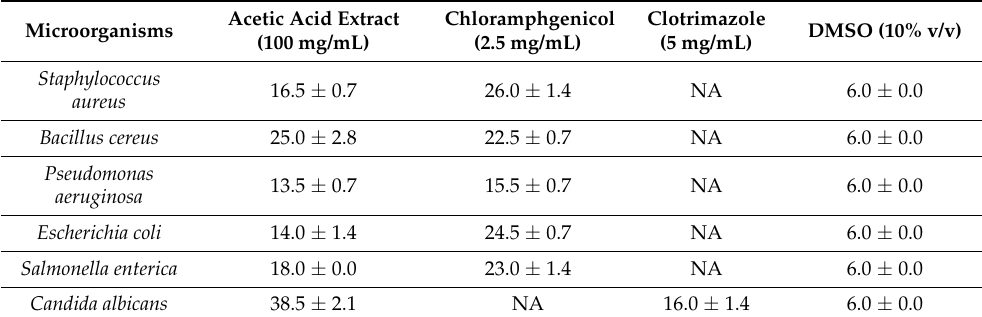
Table 2. The zones of inhibition (in mm) of Saussurea costus aqueous and acetic acid extracts against examined microorganisms (mean ± standard